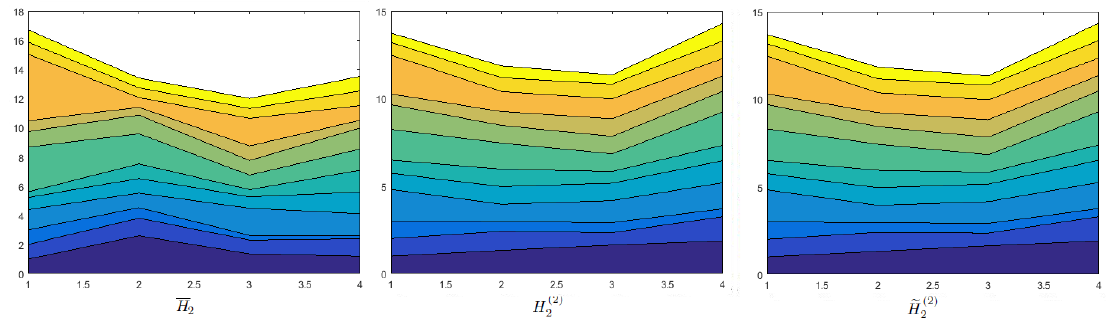
Figure 9. Area graphs of score values of H 2